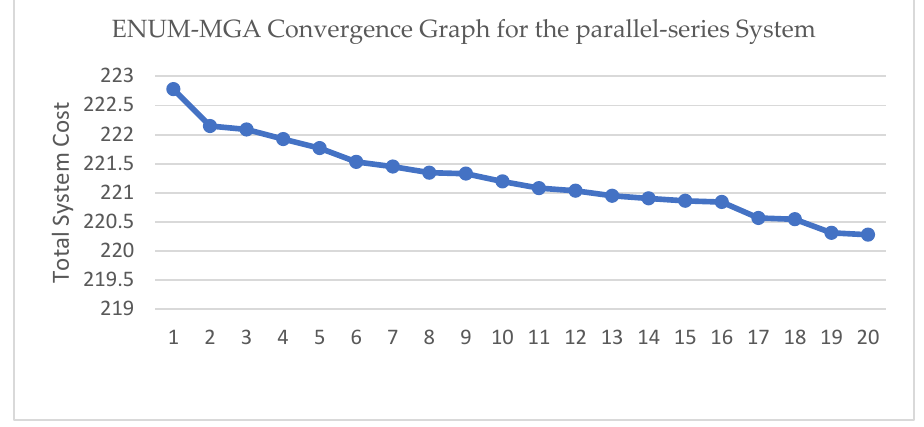
Figure 8. The convergence graph of the parallel-series system by implementing the ENUM-MGA combined method.